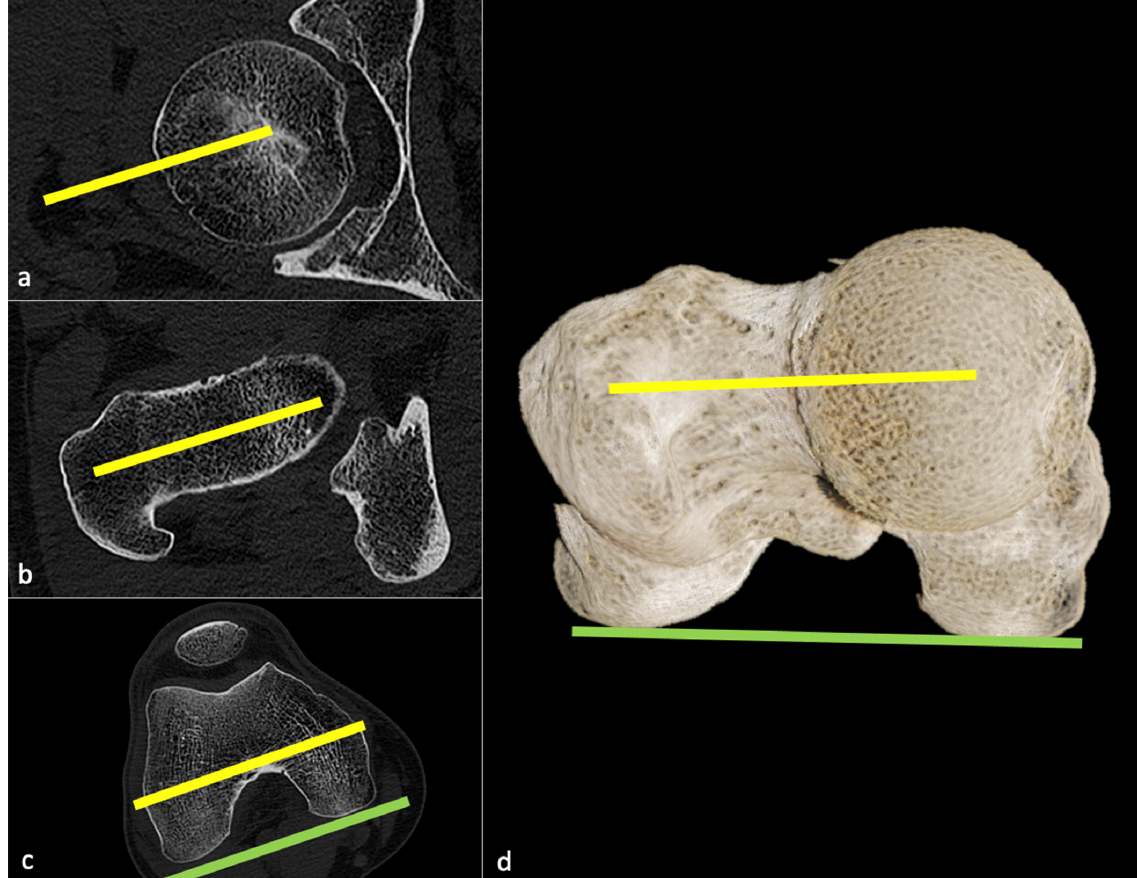
Figure 2. Femoral neck antetorsion measurement. Three axial CT slices must be selected: one shown in ( a ) at the femoral head center, one in ( b ) at the femoral neck to measure the femoral neck axis (yellow line), then one in ( c ) at the level of the roman arch to determine the intercondylar axis (green line). In ( d ), a global illumination reformat is shown to illustrate the 3D rendering of this measure, corresponding to the angle between the yellow and green lines. Hip function depends on the proper orientation of the muscles about the center of rotation of the joint (i.e., limb length imbalance and offset correction) [16]. An imbalance in GO may lead to limping due to abductor dysfunction. Reduced FO can lead to acetab ‐ ular ‐ polyethylene wear, dislocation, and loosening [15], whereas an increase can lead to residual pain and limping by exacerbation of muscle and soft ‐ tissue tension. However, it is still unclear which of these parameters (GO, FO, or AO) should be taken into account